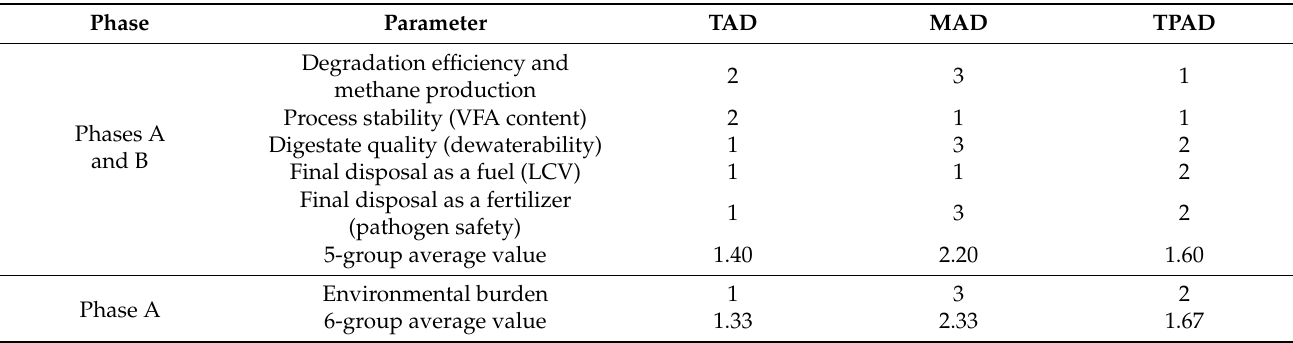
Table 13. Final comparison of TAD, MAD and TPAD.